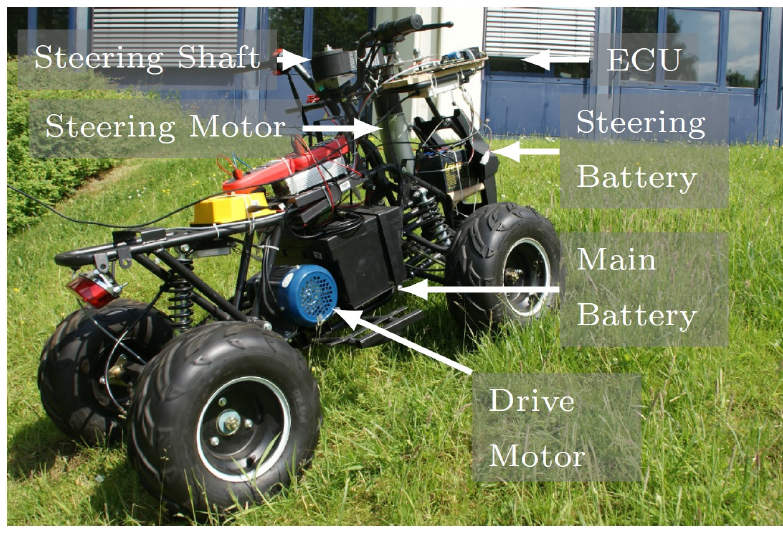
Fig. 3. Main components of the